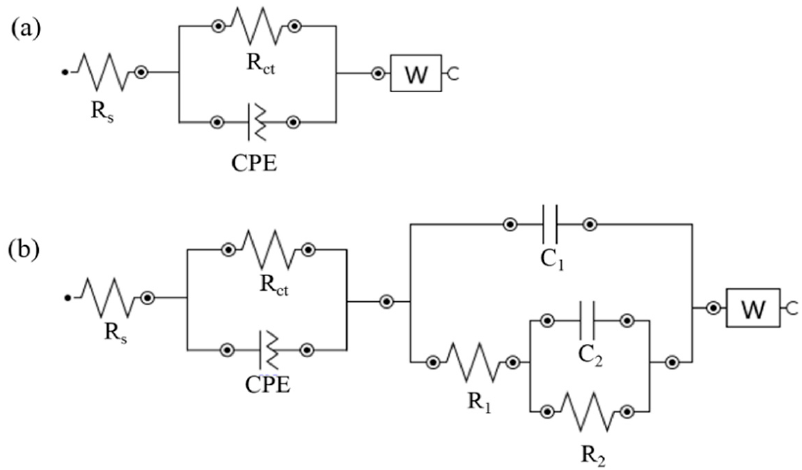
Figure 6. Equivalent circuit used to the EIS spectra for the absence ( a ) and the presence ( b ) of inhibitor in 304 SS corrosion at sulfuric acid solution.